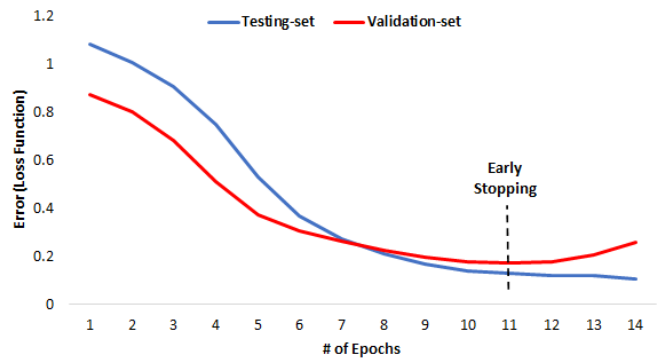
Figure 5. Example of the early stopping regularization